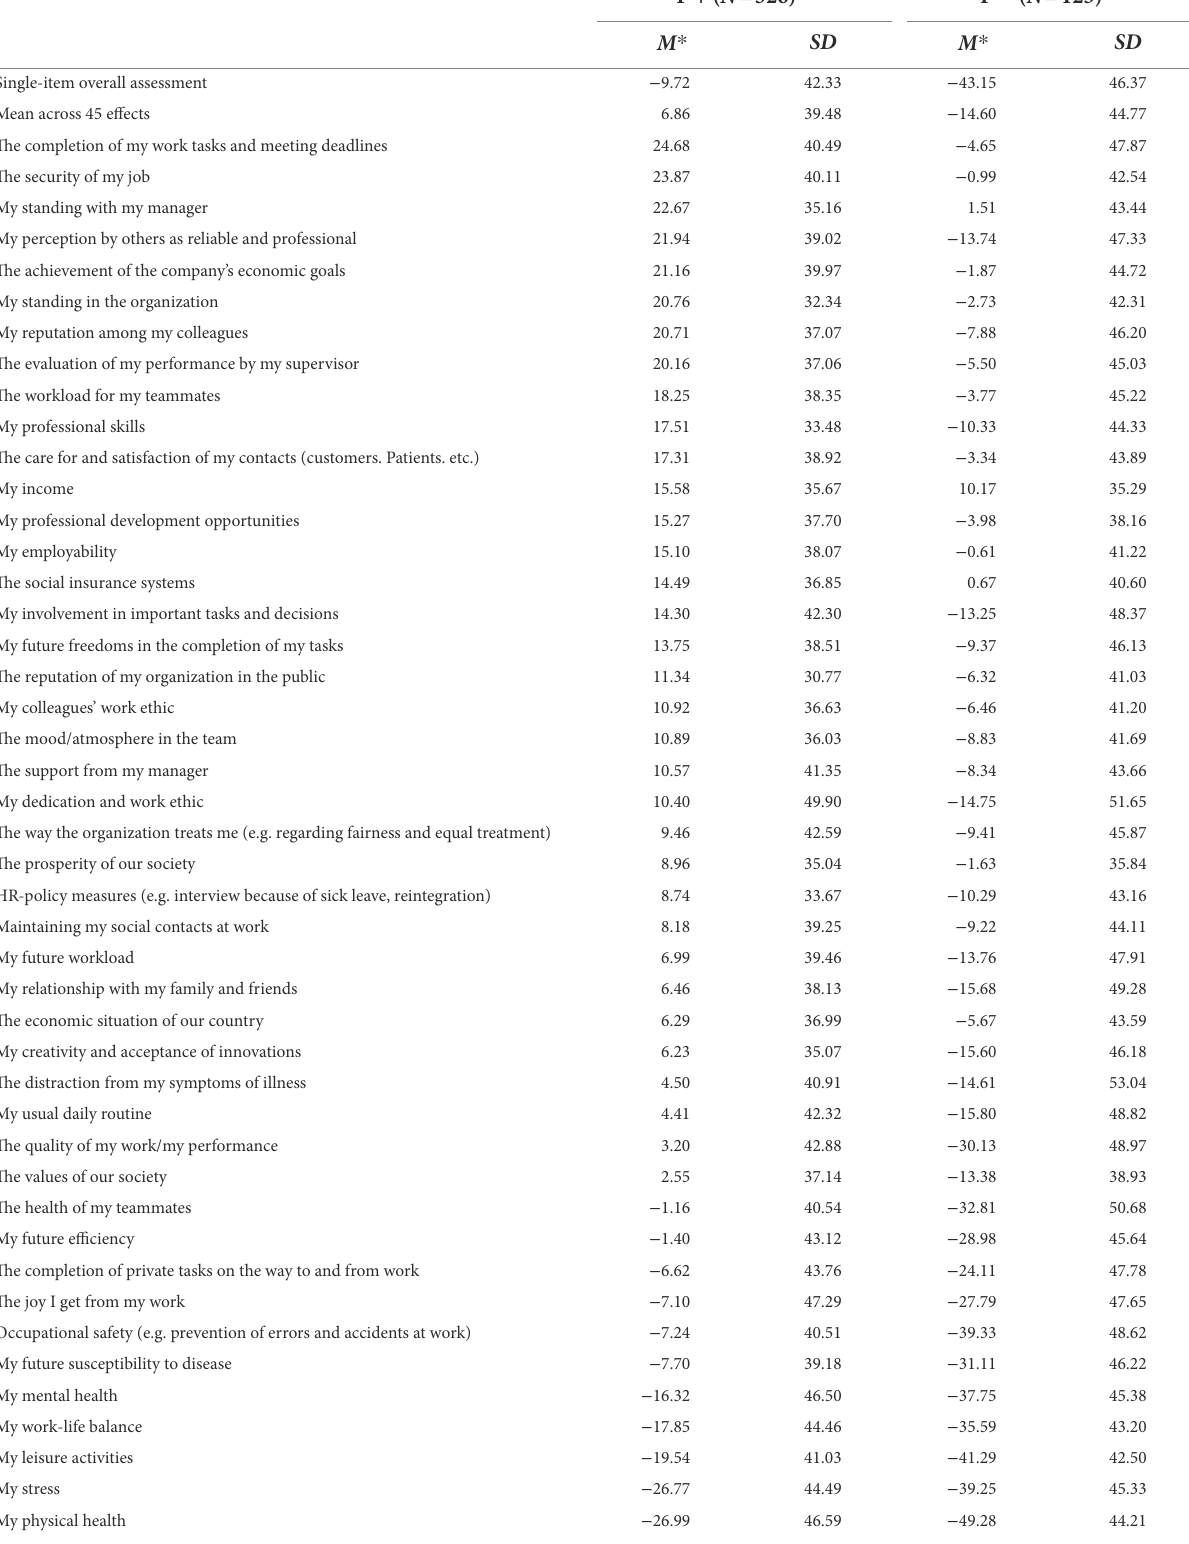
TABLE 1 Mean and SDs for single-item overall assessment, mean across 45 effects, 45 single effects for those who were ill and exhibited presenteeism (P +) and those who were ill and did not exhibit presenteeism (P −